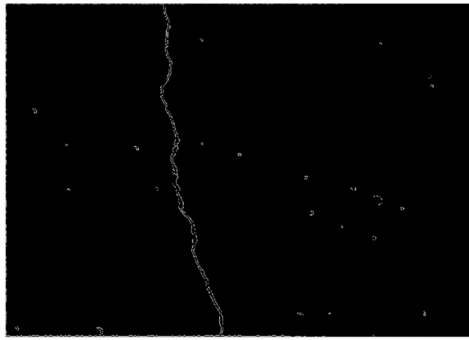
Figure 2. The processing result of the Canny operator combined with the Otsu